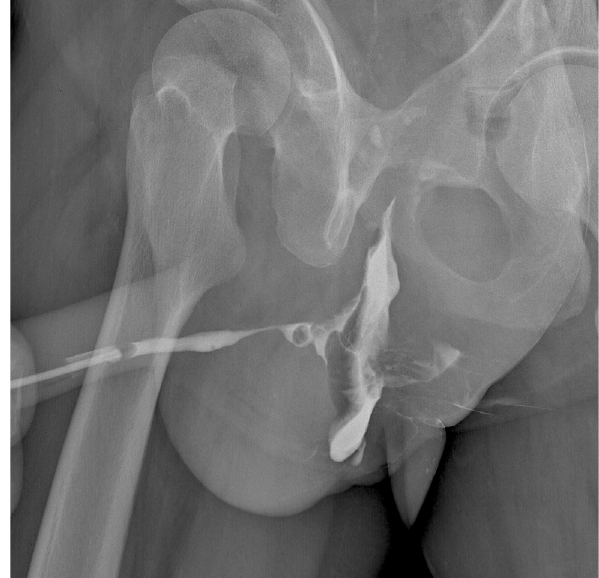
Figure 4: Retrograde urethrogram showing critical stricture of the urethra distally from the diverticulum, with fistula to the skin of the